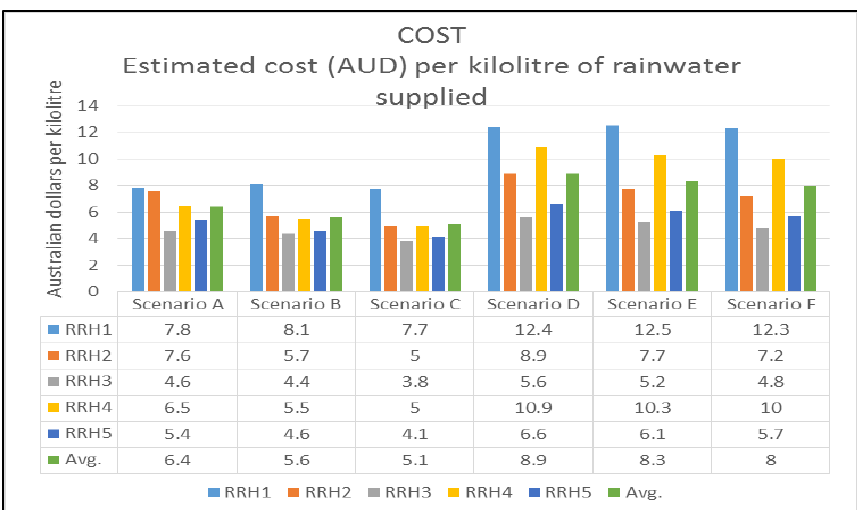
Figure 8. Comparison of RRHS modelling results — Cost per kilolitre.